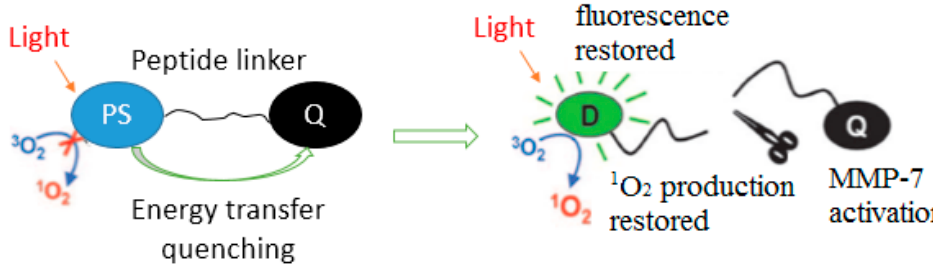
Figure 7. The concept of PMB. Copyright (2007) National Academy of Science [188].